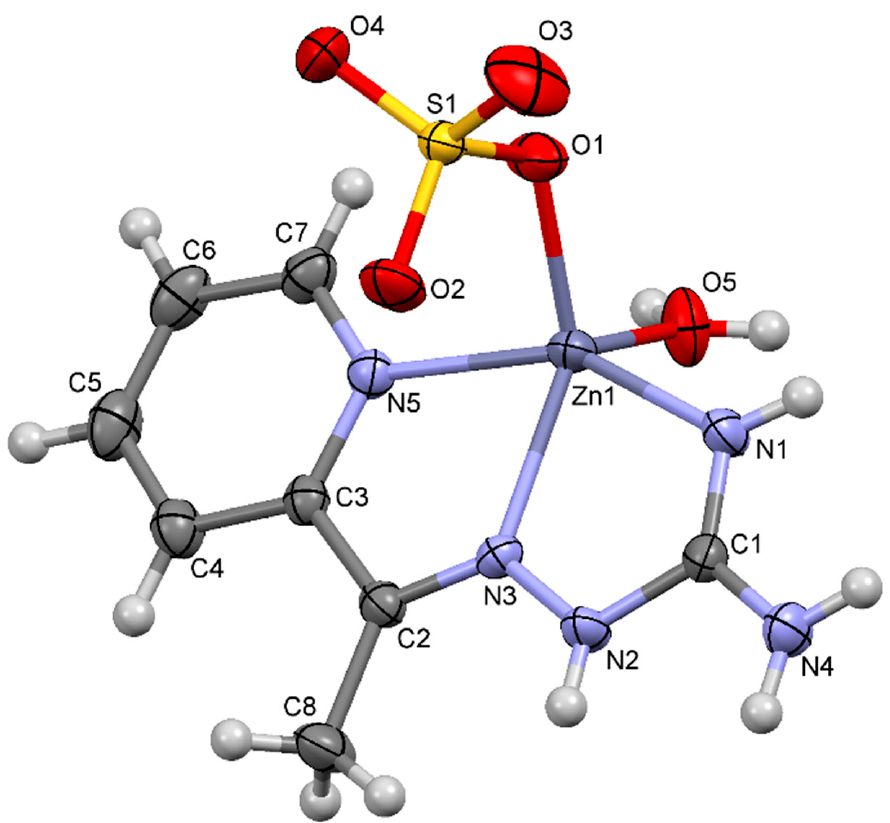
Figure 3. Molecular structure of Complex 2 . Color code: H—white; C—gray, N—violet, O—red, S—yellow, Zn—dark violet .